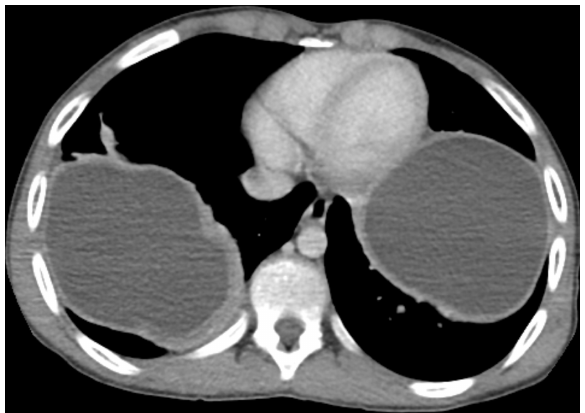
Figure 2. In a 13-year-old male, the image of giant hydatid cysts located in the lower lobe of the right lung and the lower lobe of the left lung is seen in the thorax computed tomography mediastinal window.